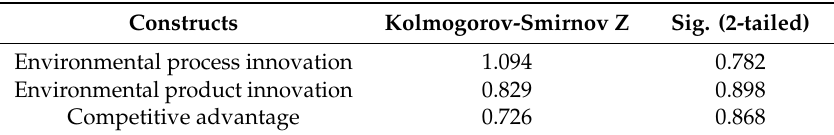
Table 7. One-sample Kolmogorov–Smirnov test.